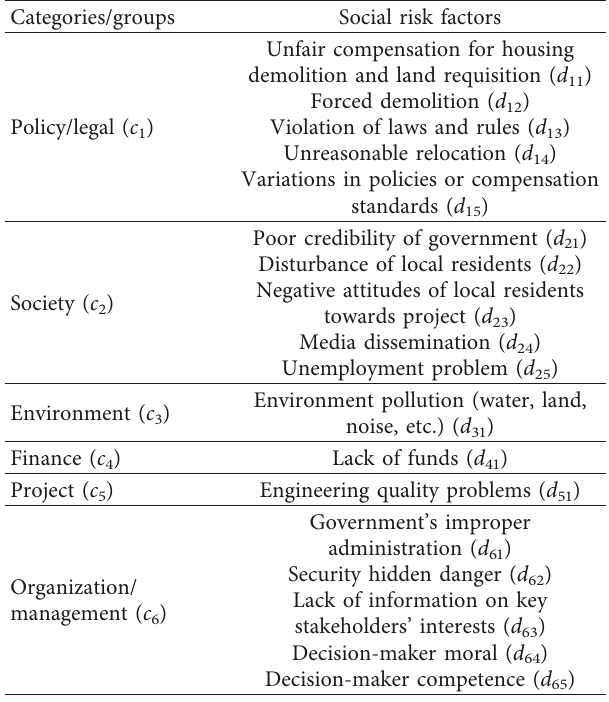
Table 4: Critical risk factors and